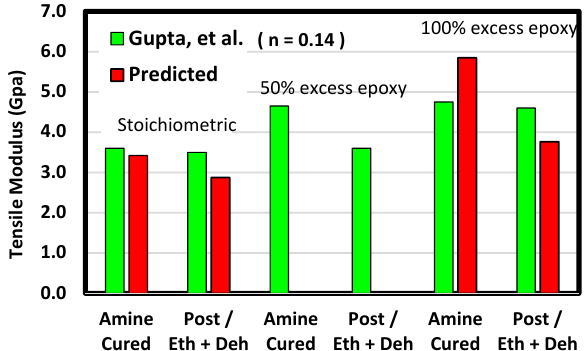
Figure 16. Predicted tensile modulus for the short-chain system compared with the experiments of Gupta et al. [6]. Amine-cured moduli for the same formulation are plotted together. Results from post-curing experiments and predictions including both etherification and dehydration are plotted next to each other.